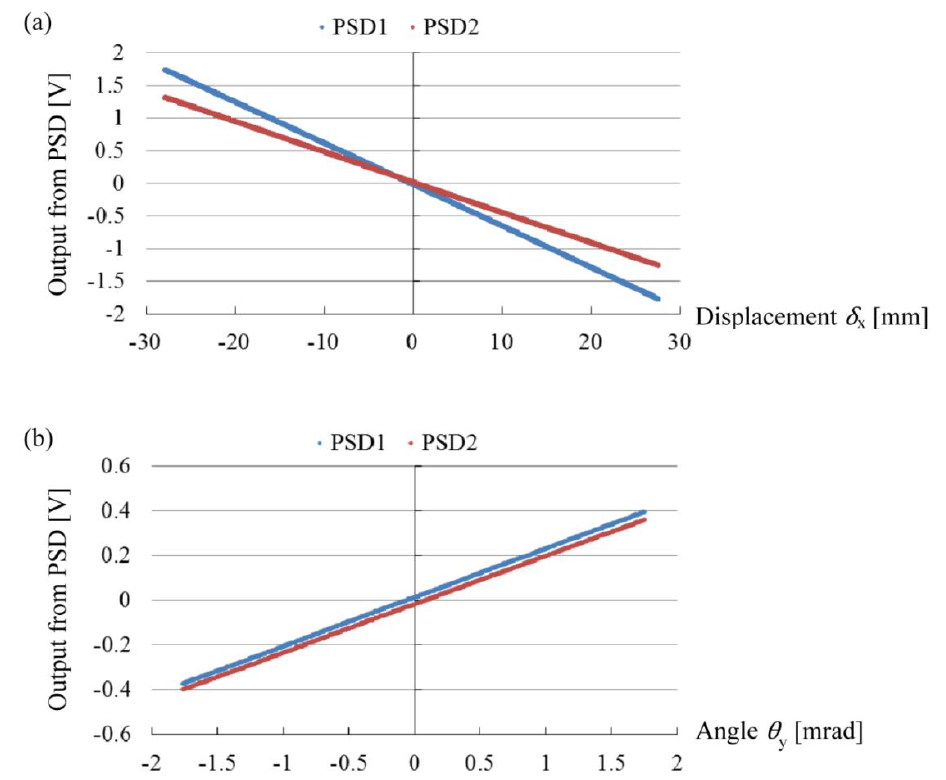
in the static y